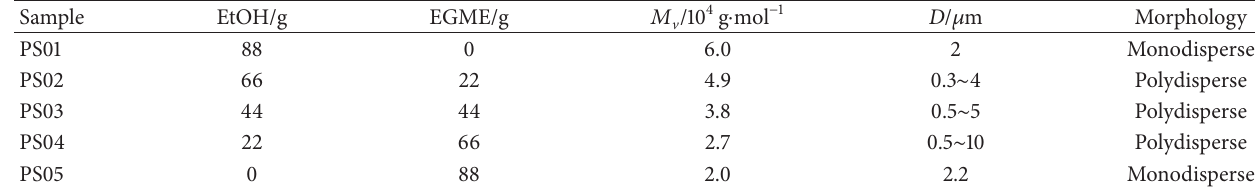
Table 2: Effect of ethanol content on the polystyrene microspheres.